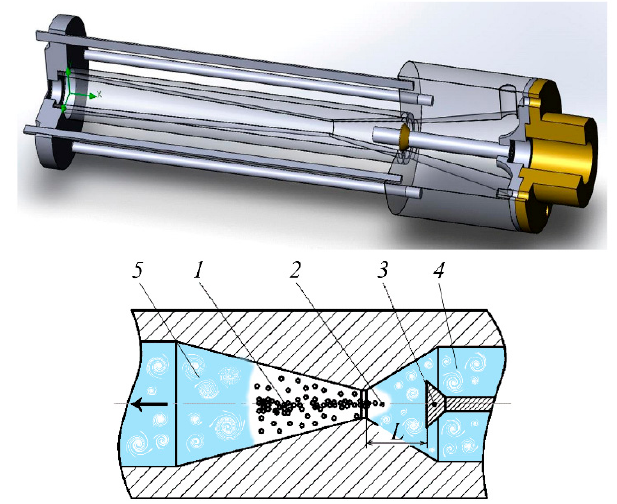
Figure 1. Static cavitation device: 1—active processing area (cavitation flow); 2—narrowed area; 3—cone; 4,5—turbulent flow; 𝐿 —the distance between the nozzle and the obstacle.